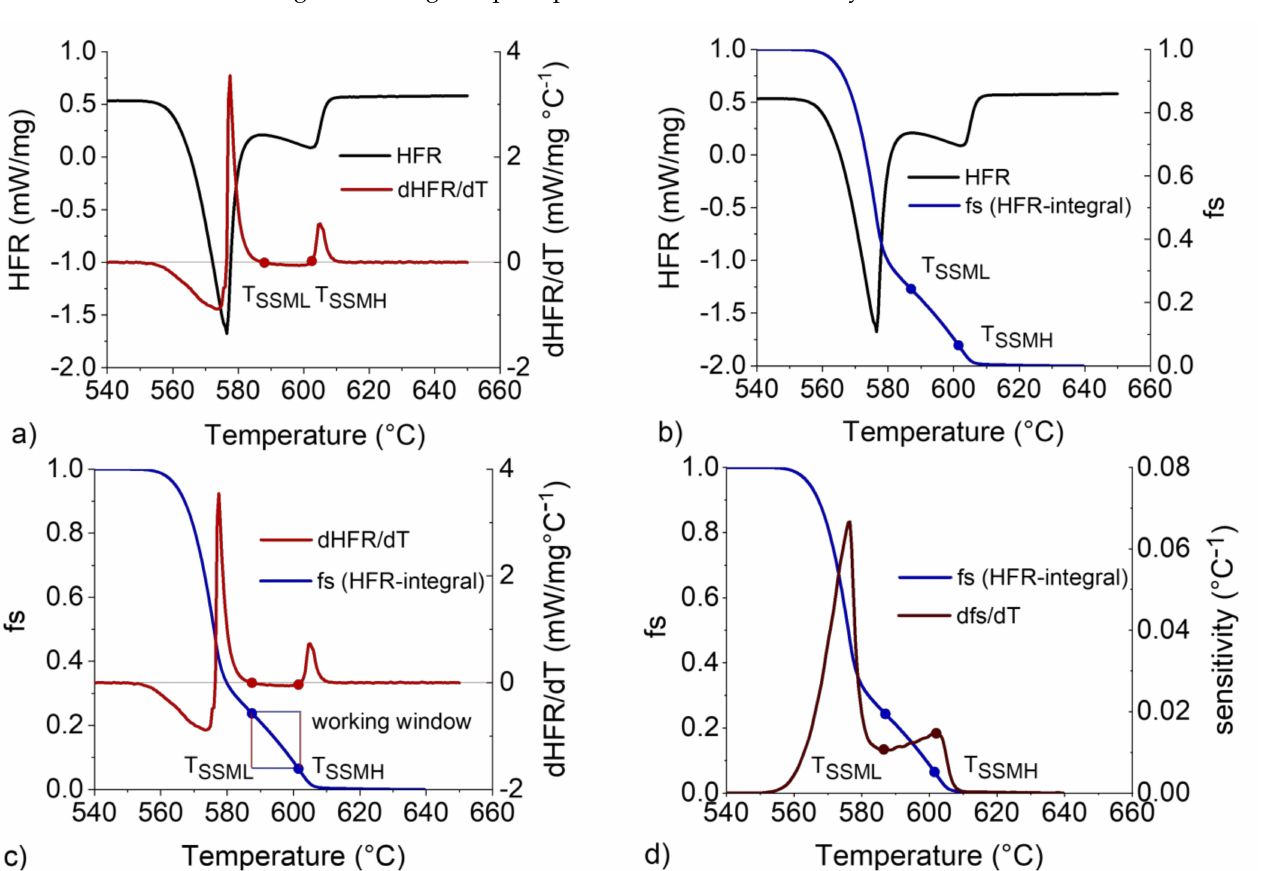
Figure 5. HFR vs. T (black), dHFR/dT vs. T (red), fs vs. T (dark blue) and dfs/dT vs. T (light blue) curves for Al 7 Si 4 Zn alloy with a 5 ◦ C/min heating rate and 20 mg sample mass; the temperatures/solid fractions at the beginning ( SSML ) and end ( SSMH ) of the thixoforming processing working window are shown as solid dots. ( a ) Firt step-obtaining of the dFHR/dT/dT from FHR , ( b ) Second step-Partial integration of the HFR curve to obtain the fs × T curve, ( c ) derivative curve of the solid fraction as equivalent of the sensitivity, ( d ) solid fraction and its corresponding sensitivity as a function of